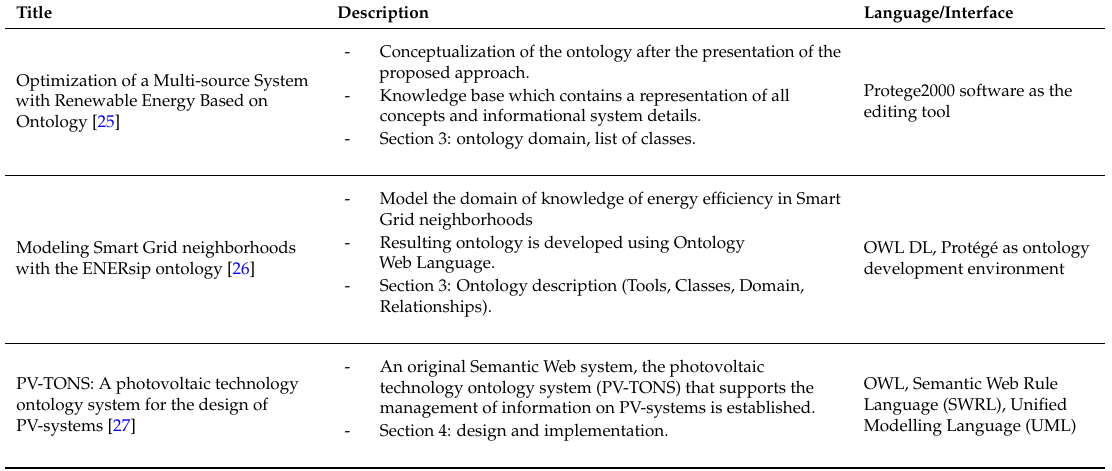
management of information on PV-systems is established. - Section 4: design and implementation.